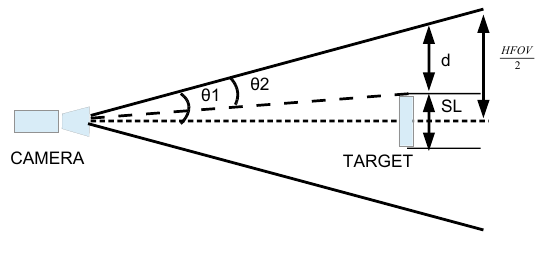
Figure 16. Maximum